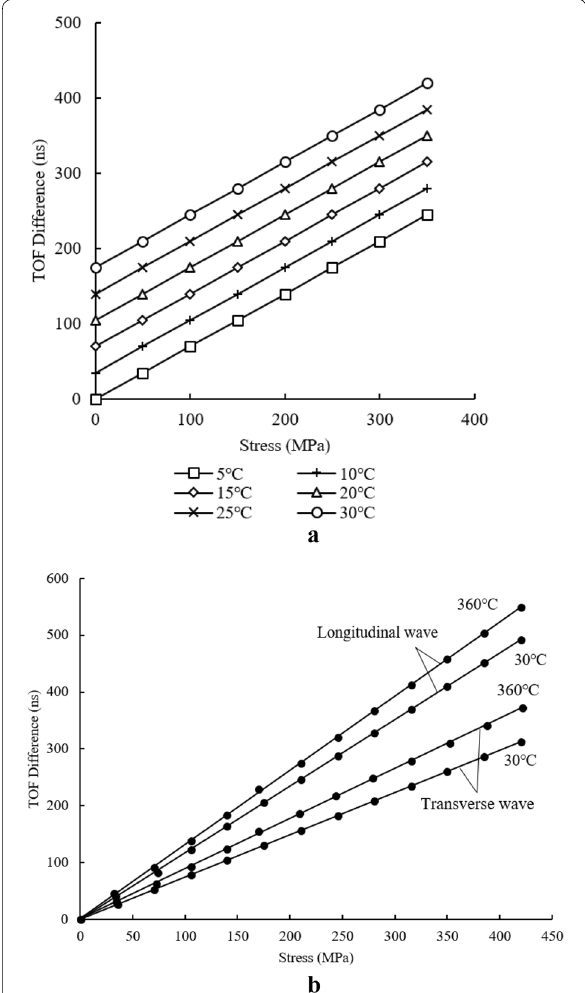
Figure 16 Relationship between the TOF difference and stress [35, 56]: a small change in temperature, and b significant change in